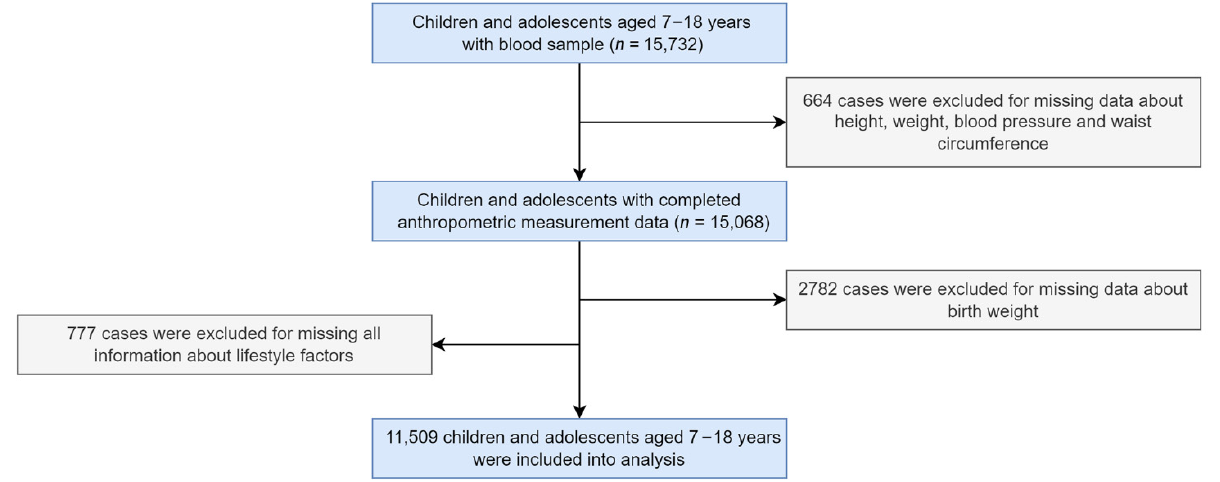
Figure 1. Flow diagram of participants’ inclusion.